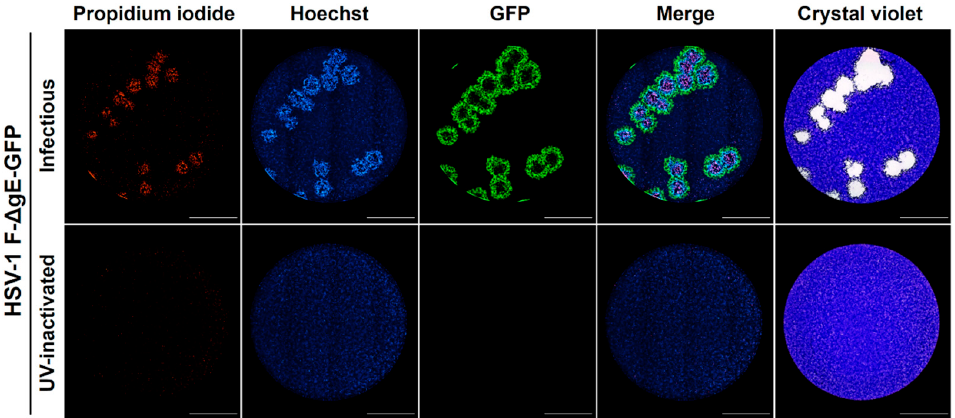
Figure 4. Comparison of DNA fluorescent dyes with a transgenic fluorescent virus for the identifi- cation of individual viral plaques by live-cell imaging. Vero cells were inoculated with either infec- tious or UV-inactivated HSV-1 F- Δ gE-GFP fluorescent virus, cell nuclei were Hoechst stained, and cells were subjected to plaque assay for 120 h with a medium containing the cell death dye propid- ium iodide. Viral plaques were confirmed by the standard crystal violet staining. Both fluorescent approaches allowed the identification of all plaques present in the samples analyzed. A representa- tive experiment is shown (n = three independent experiments), total magnification of 40X, scale bar = 2000 µm.